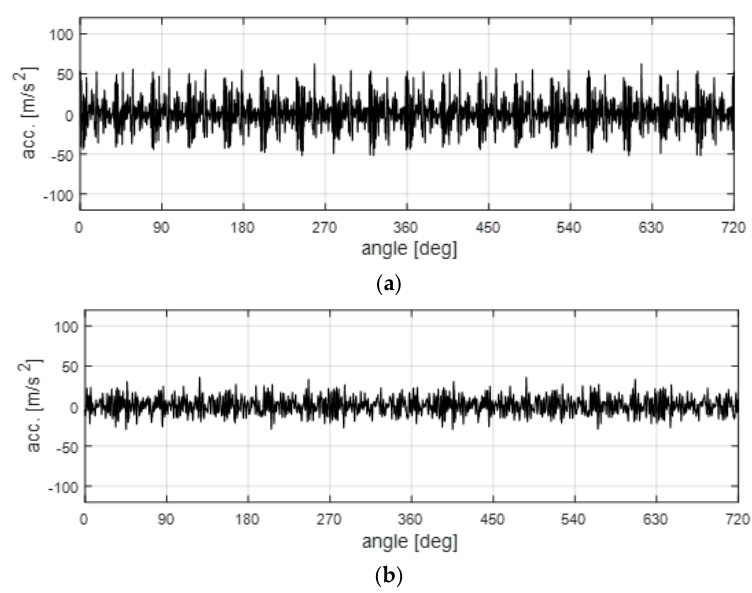
Figure 7. Synchronous average for ( a ) the flawless pump and ( b ) faulty pump for the signal acquired with sensor 2 (1500 r/min, 150 bar).